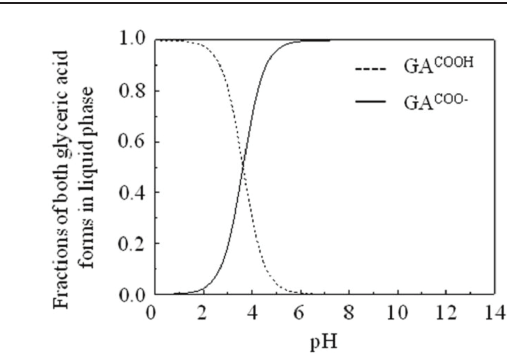
Fig. 2 – Effect of the pH on D-GA